Question: Write a single sentence explaining what this figure depicts.
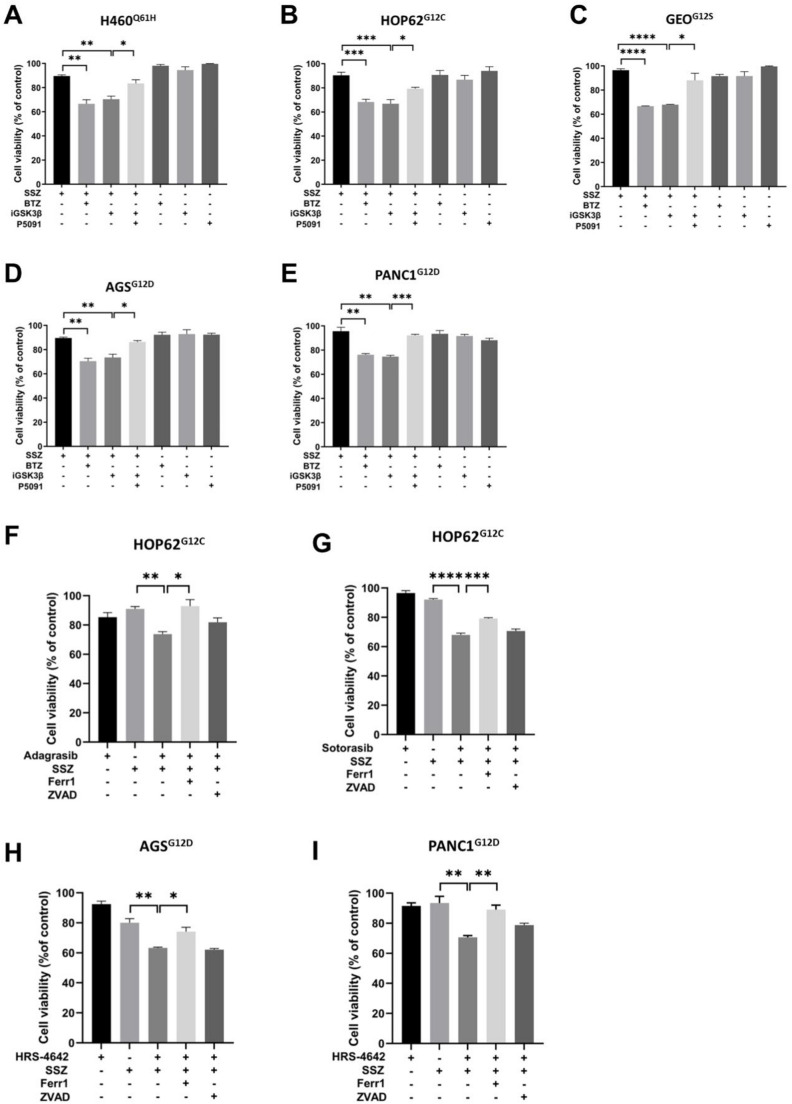
Answer: Inhibition of CCDC6 protein degradation enhances sensitivity to ferroptosis inducers. A–E Cell viability was assessed in H460 ( A ), HOP62 ( B ), GEO ( C ), AGS ( D ) and PANC1 ( E ) cells treated with the ferroptosis inducers Sulfasalazine (SSZ), the proteasome inhibitor Bortezomib (BTZ), the GSK3β inhibitor SB216763 (iGSK3β), or the USP7 deubiquitinase inhibitor (P5091), either alone or in combination. The drug concentrations were as follows: SSZ at 800µM (H460), 200µM (HOP62, PANC1, GEO), 1 mM (AGS); BTZ at 5 nM (H460, AGS, PANC1), 10 nM (HOP62), 4nM (GEO); iGSK3β at 10 µM (H460), 40 µM (HOP62), and 20 µM (AGS, PANC1, GEO); P5091 at 2.5 µM (H460), 1µM (HOP62, AGS, PANC1, GEO). F–G HOP62 cell viability was measured after treatment with Sulfasalazine (SSZ) [400µM], used alone or combined with the KRASG12C inhibitors Adagrasib [2µM] ( F ) or Sotorasib [40µM] ( G ). The ferroptosis inhibitor ferrostatin-1 (Ferr1) [10 µM] or the pan-caspase inhibitor Z-VAD-fmk (ZVAD) [10 µM] were added to the SSZ-containing combinations. H–I Cell viability was assessed in AGS ( H ) and PANC1 ( I ) treated with Sulfasalazine (SSZ), [1mM] in AGS and [200µM] in PANC1, used alone or combined with the KRASG12D inhibitor HRS4642, [6nM] in AGS and [5µM] PANC1. The ferroptosis inhibitor ferrostatin-1 (Ferr1) [10 µM] or the pan-caspase inhibitor Z-VAD-fmk (ZVAD) [10 µM] were added to the SSZ-containing combinations. Where shown, data are reported as mean ± SEM of 3 independent repeats. Statistical significance was verified by 2-tailed Student’s t-test (* p < 0.05; ** p < 0.01, *** p < 0.001 and **** p < 0.0001)